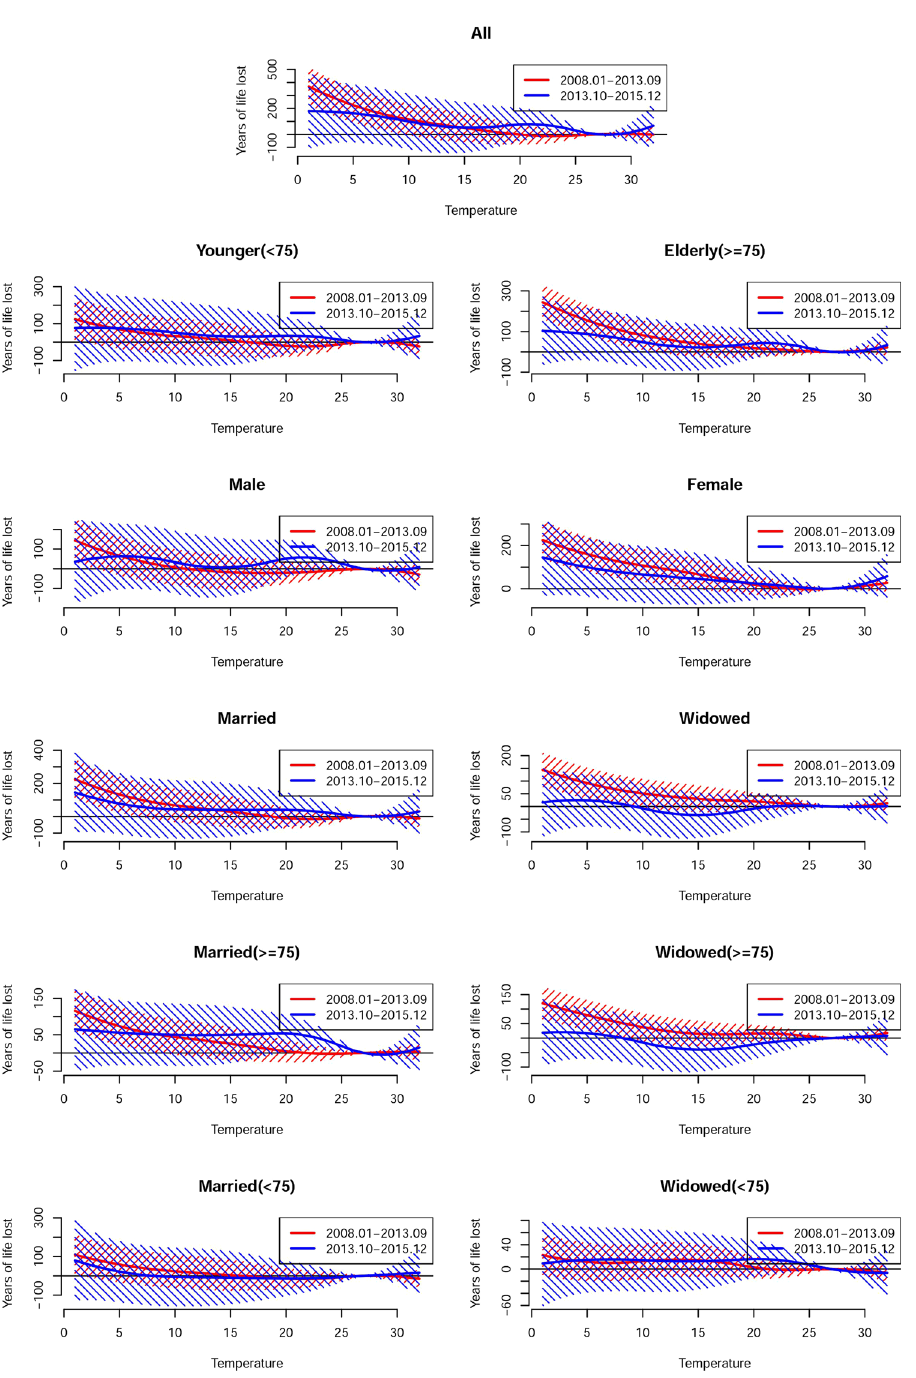
Figure 4. Overall cumulative exposure-response curves (with 95% confidence intervals) for the association between temperature and years of life lost due to cardiovascular mortality during period I (Jan 2008 to Sep 2013) (red) and period II (Oct 2013 to Dec 2015)